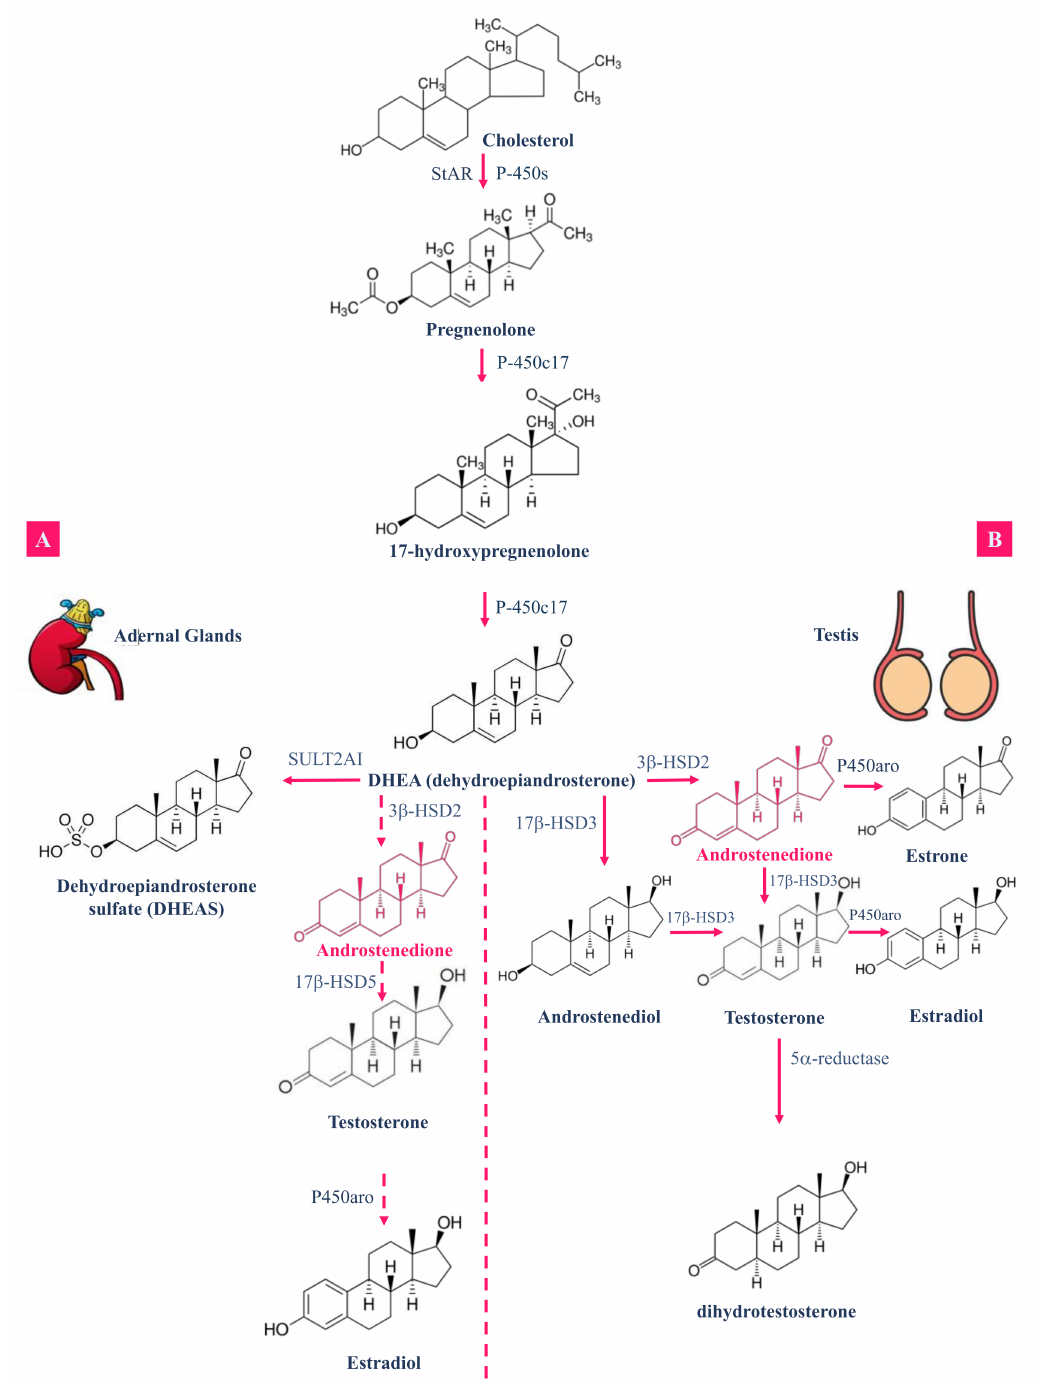
Figure 4. Production of steroidal hormones from cholesterol, including androstenedione production by the enzyme 3ß-HSD2 in both adrenal glands ( A ) and testis ( B ), as well as the production other essential androgens throughout the enzymatic reaction. Androstenedione is highlighted in pink in both cycles. Enzyme codes are: Steroidogenic Acute Regulatory protein (StAR), Cytochromes P450, Sulfotransferase (SULTs), 3- β hydroxysteroid dehydrogenase (3 β -HSD), and aromatase cytochrome P450